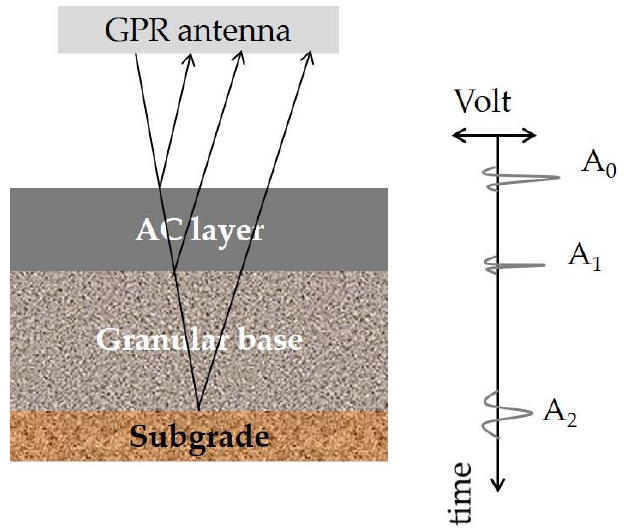
Figure 3. Operation principles of Ground Penetrating Radar (GPR) (adapted from [28]. Copyright 2020 Elsevier).